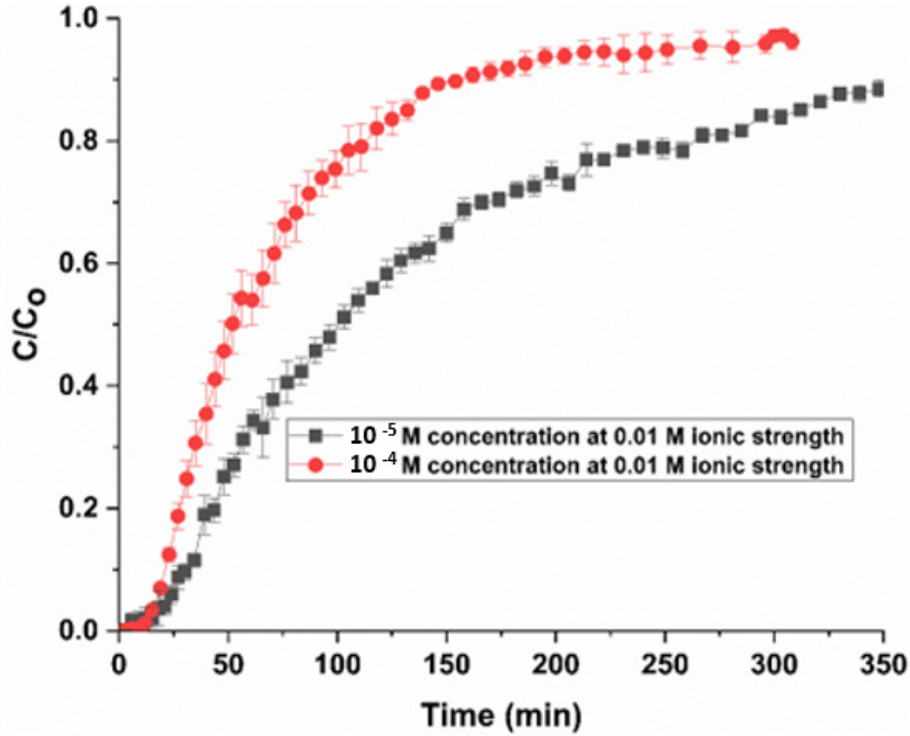
Figure 5. Selenite breakthrough curves at 0.01 ionic strength at two selenite initial concentrations. The breakthrough curves for the average of three experimental trials at two ionic strength values (0.01 M and 1 M) for the 10 − 4 M selenite concentration are shown in Figure 6. The breakthrough curves of the 0.01 M and 1.0 M ionic strengths show the neglected effect of this variable on selenite sorption onto modified zeolite. This negligible effect is due to the selenite sorption mechanism on the amphoteric sites. Selenite binds strongly and forms inner-sphere complexes with these surfaces. Thus, these bonds are not affected by ions present in the solution. Hence, the shape of the breakthrough curves was almost the same under the two studied ionic strengths. The time required for breakthrough saturation and the ability of modified zeolite to retard the mobility of selenite were almost the same under the studied ionic strength concentrations, as demonstrated in Figure